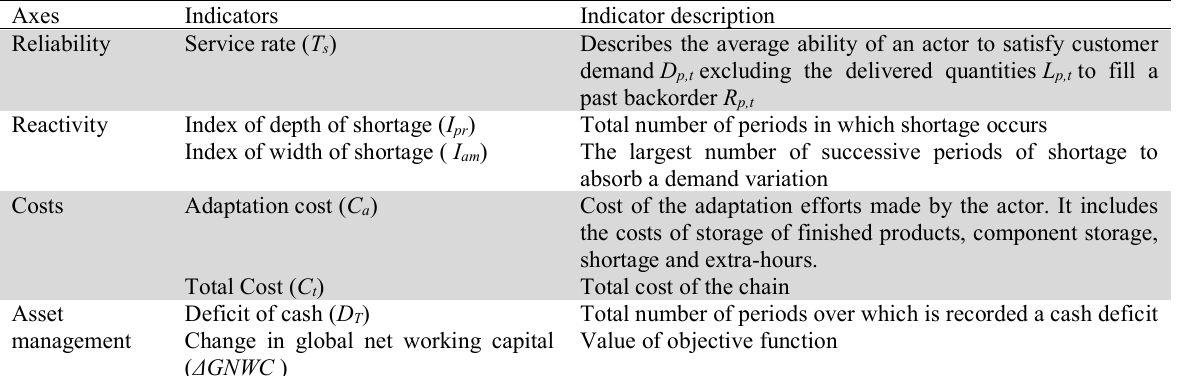
Performance of the approach